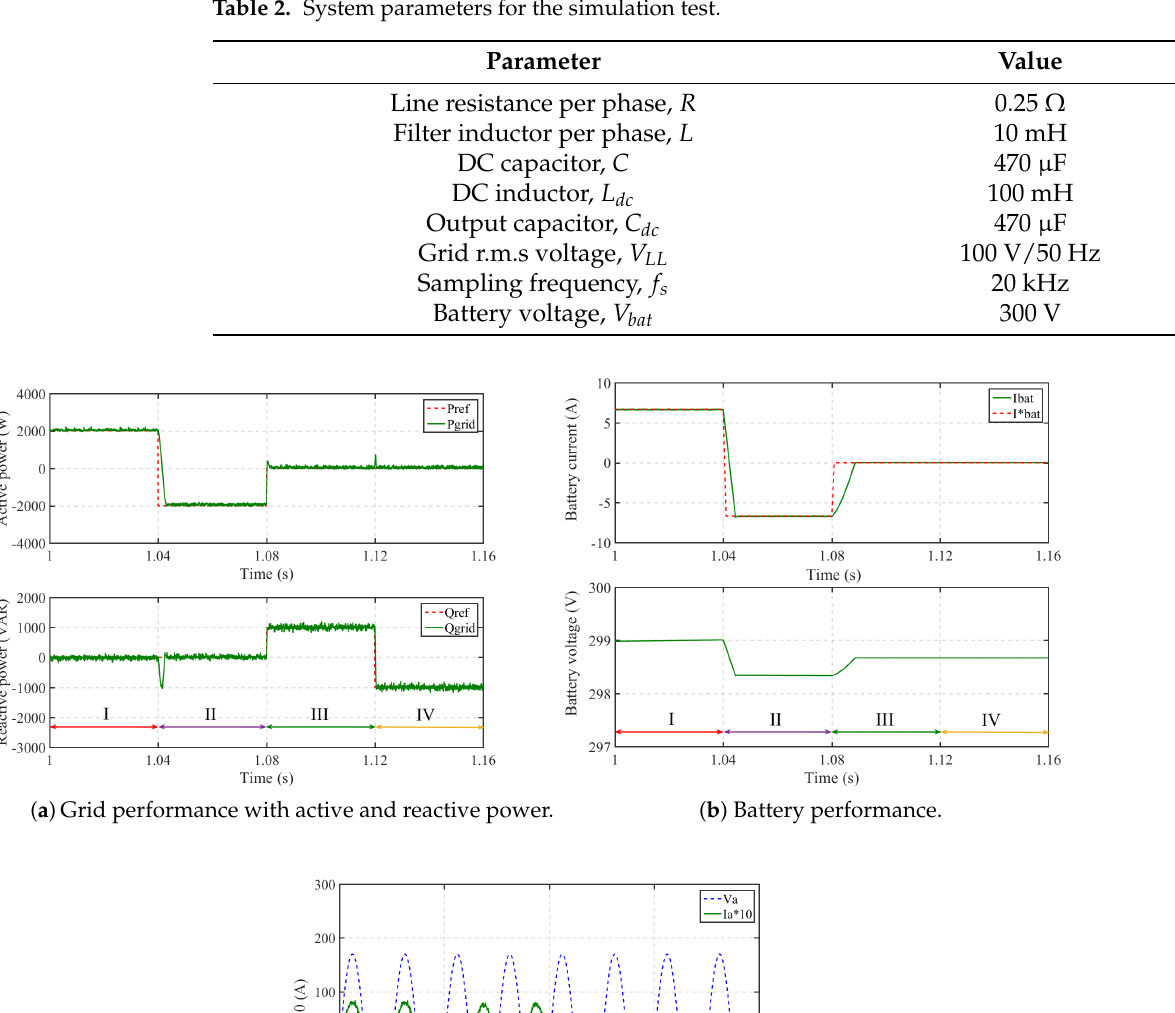
Table 2. System parameters for the simulation test.